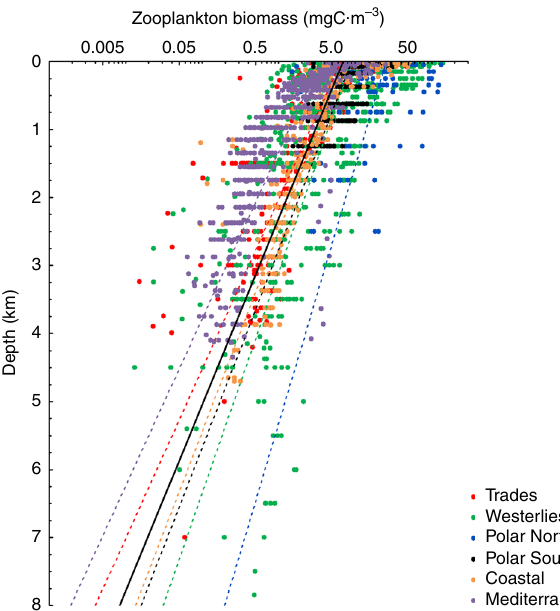
Fig. 1 Vertical distribution of zooplankton biomass. Vertical pro fi les of zooplankton biomass in different oceanic biomes as de fi ned by Longhurst et al. 14 . Dotted lines represent the fi tted regression equations shown in the Supplementary Table 1. Black line is the general equation for all the data, also given in the Supplementary Table 1. Note that the X -axis is in logarithmic